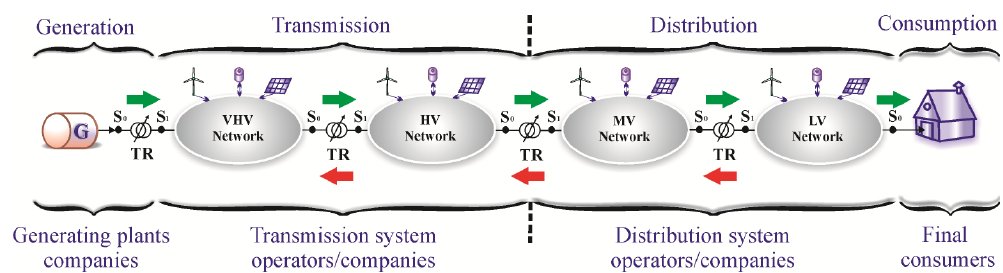
Figure 1. Conceptual structure of a future power system [2]. Here, S 0 stands for the primary side while S 1 for the secondary side of a transformer (TR) which is located between two different voltage levels.